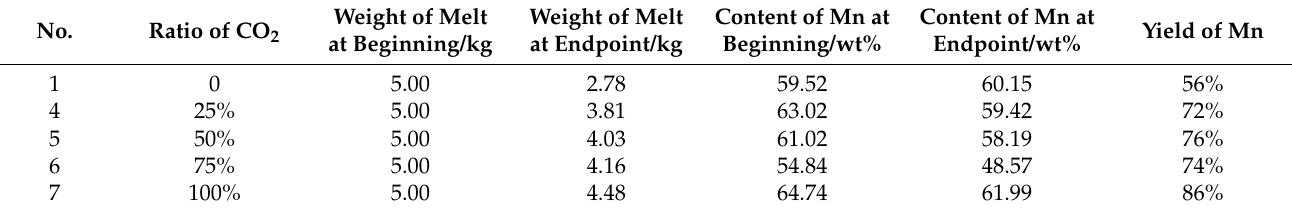
Table 4. The manganese yield of formal experiments.